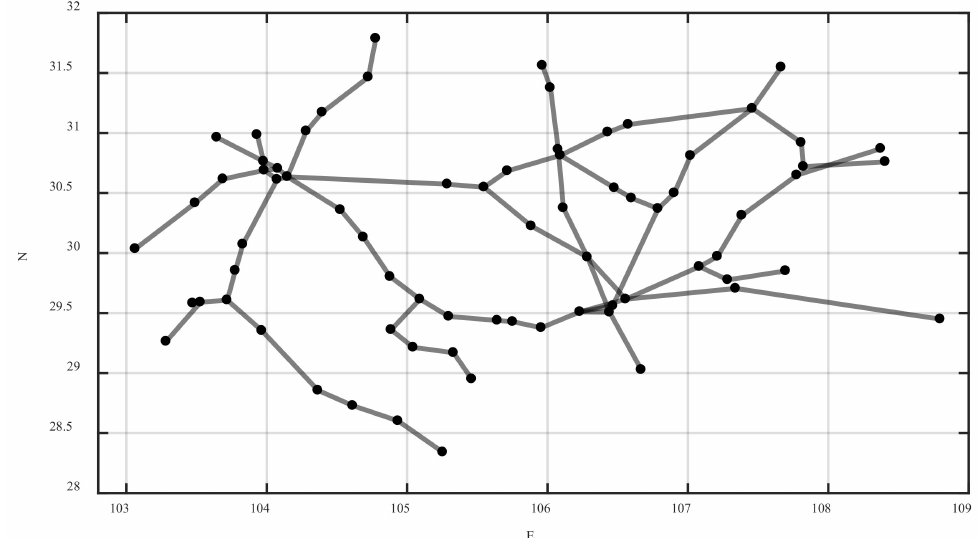
Figure 5. The railway passenger transport network of the Chengdu–Chongqing urban agglomeration.